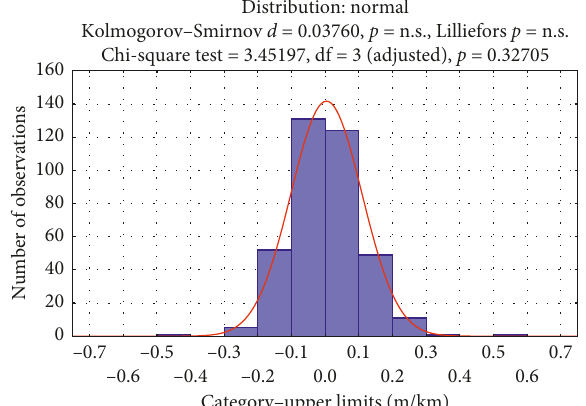
Figure 10: Distribution of prediction errors of the SVM